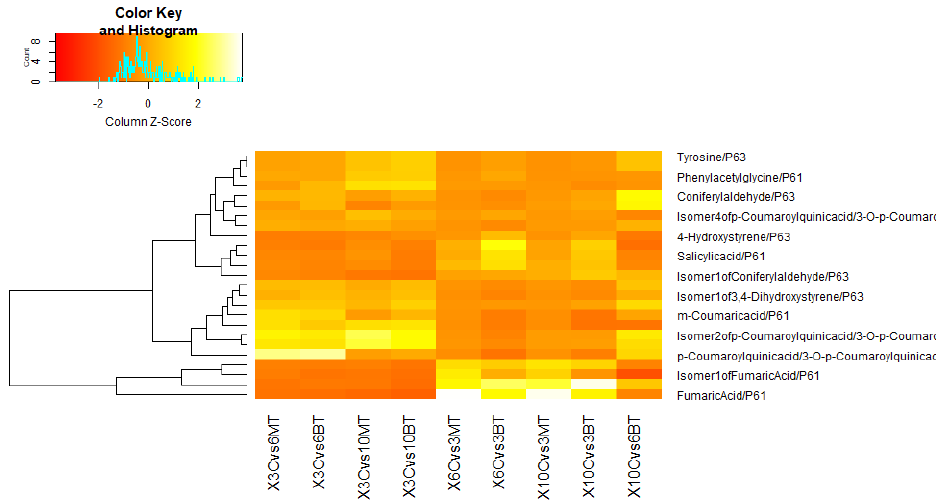
Figure 9. Heat map showing some of the differentially expressed metabolites of C5-branched dibasic acid metabolism (P17) and Citrate Cycle (TCA cycle) (P23) pathways in different comparisons between positive control plants (C) and Metarhizium (MT) or Beauveria (BT) treatments at different Dpi. Z score is a measure of distance, in standard deviations, from the plate mean. A well with a Z score of 0 has the same raw value as the plate mean. A well with a Z score of 1.0 is exactly one standard deviation above the plate mean and a Z score of −0.5 is half a standard deviation below the plate mean.